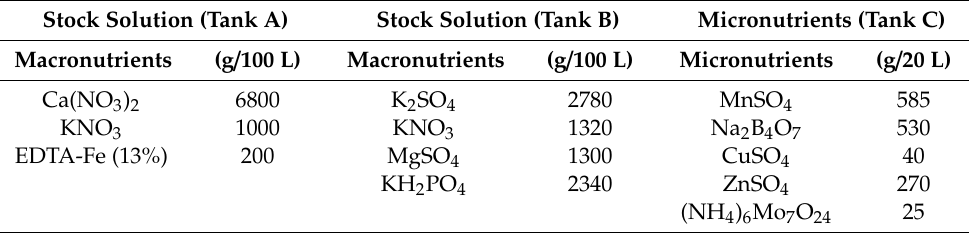
Figure 2. Plant arrangement in the CONV (Conventional) ( a ) and DSSC (Dye-Sensitized Solar Cell) ( b ) greenhouses. The di ff erence in the shading within the greenhouses is visible. Table 1. Chemical characteristics of the nutrient solutions used in the experiments.